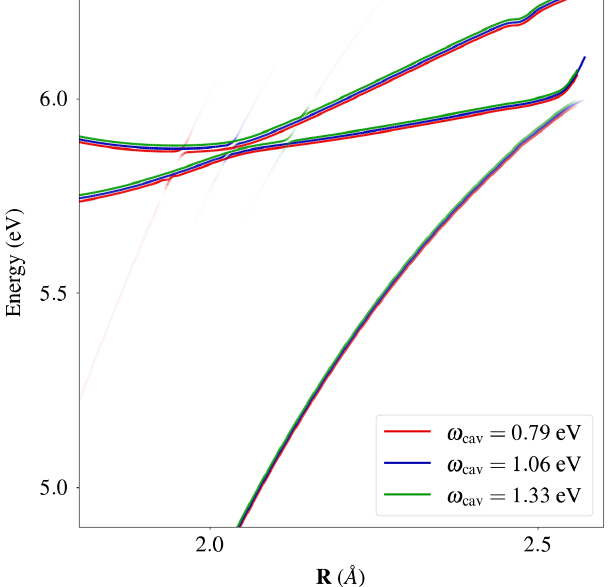
FIG. 12. Potential energy curves in QED-CCSD-1 for pyrrole with cavities at different frequencies ω λ ¼ 0 . 05 , and with cc-pVDZ. The energies are relative to equilibrium